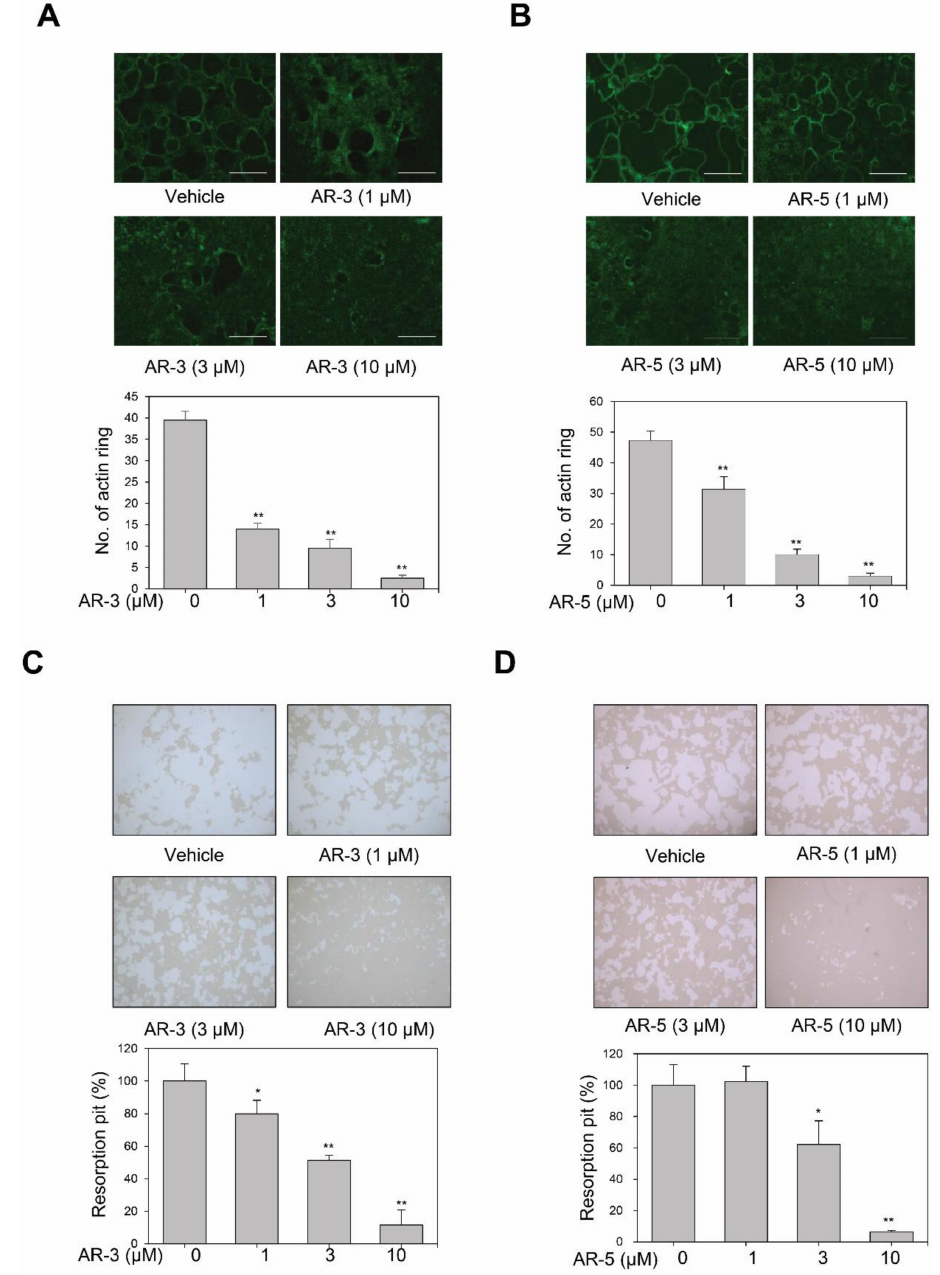
Figure 3. AR-3 and AR-5 inhibit RANKL-induced actin-ring formation and resorption pits in BMMs. ( A , B )BMMswereincubatedwithM-CSFandRANKLinthepresenceofindicatedconcentrationsofAR-3 ( A ) or AR-5 ( B ) for seven days. Actin-ring positive osteoclasts were visualized with FITC-conjugated phalloidin (scale bar: 500 µ m). Data are presented as the mean ± SE (** p < 0.01, versus vehicle-treated control; n = 3). ( C , D ) BMMs were cultured on Corning OsteoAssay Surface 96 well-plates, and incubated with M-CSF and RANKL in the presence of indicated concentrations of AR-3 ( C ) or AR-5 ( D ) for seven days. The cells were removed and pit area was measured by ImageJ software. Data are presented as the mean ± SE (* p < 0.05 and ** p < 0.01, versus vehicle-treated control; n =